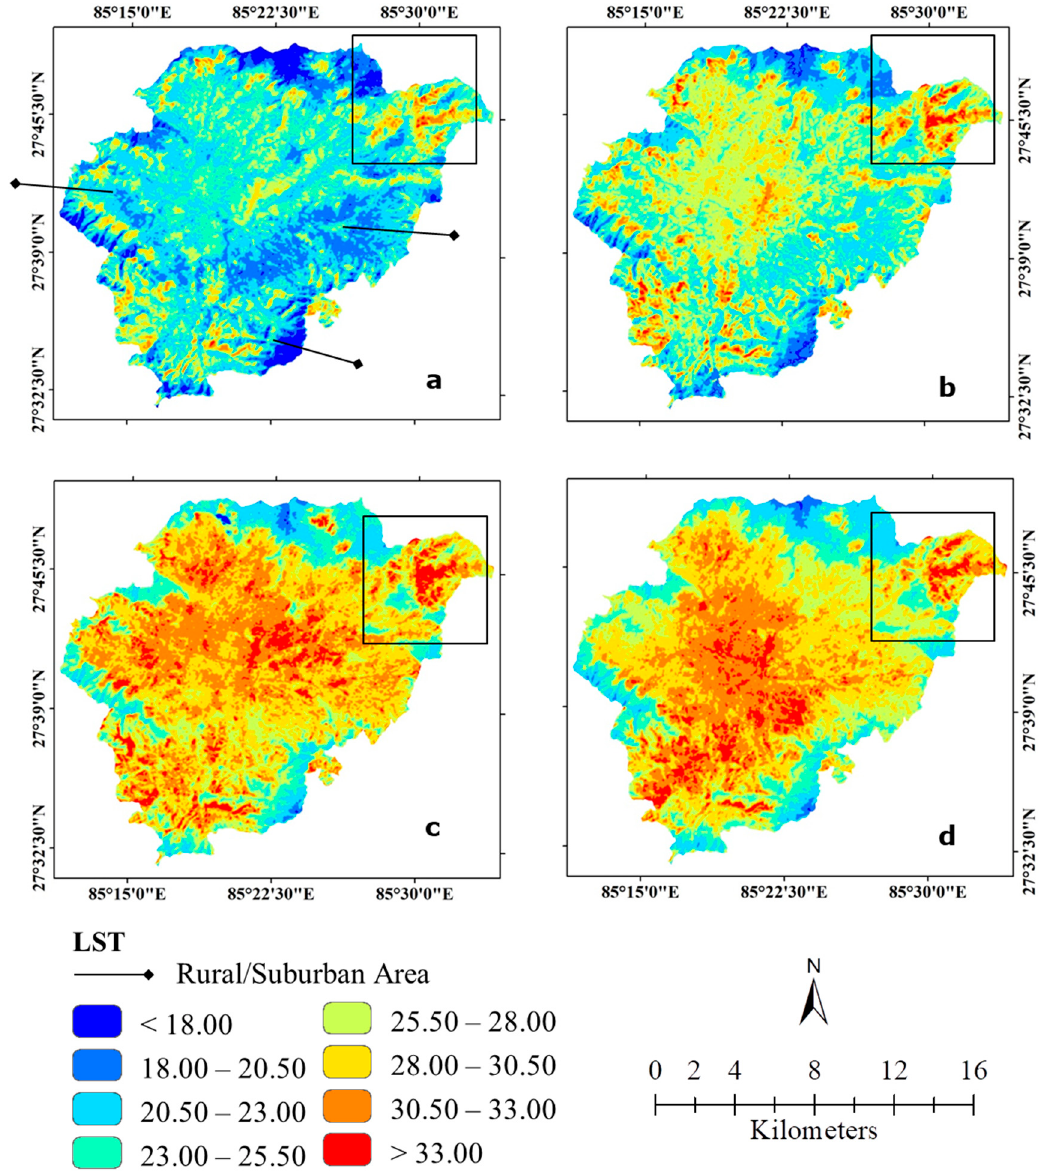
Figure 4. Spatial distribution of LST (°C) for Kathmandu in ( a ) 1988; ( b ) 1998; ( c ) 2008; ( d ) 2018. In 4 ( a ) the three points indicate rural/suburban areas used for the analysis of Surface Urban Heat Island (SUHI) (see Figure 2). Square box transect over all LST (°C) maps ( a – d ) is to show the effects of agricultural land on LST dynamics.